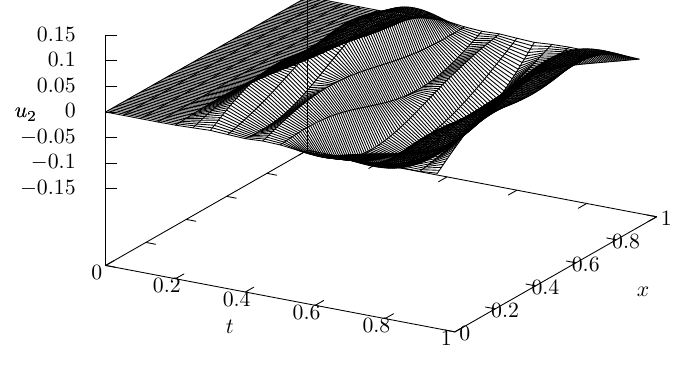
Figure 3. The numerical solution of the elastic in Equation (88) without the damping terms. Although there exist no wave in the initial state, some waves are excited due to the energy exchange.